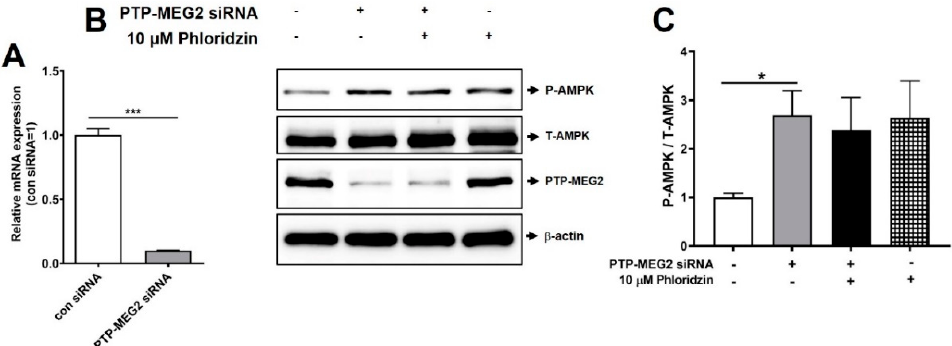
Figure 2. Suppression of PTP-MEG2 enhanced AMPK phosphorylation. ( A , B ) 3T3-L1 preadipocytes were transfected with 30 nM PTP-MEG2 siRNA or scrambled siRNA as a control (con). After 72 h, cells were lysed and analyzed by quantitative real-time PCR ( A ) or Western blotting ( B ). ( C ) Quantification of phospho-AMPK/total-AMPK using the ATTO image analysis software (CS analyzer 4). All experiments were independently repeated at 3 times. Results are presented as mean ± standard error of the mean (SEM). *** p < 0.001, * p < 0.05 compared to the control siRNA condition (con siRNA).